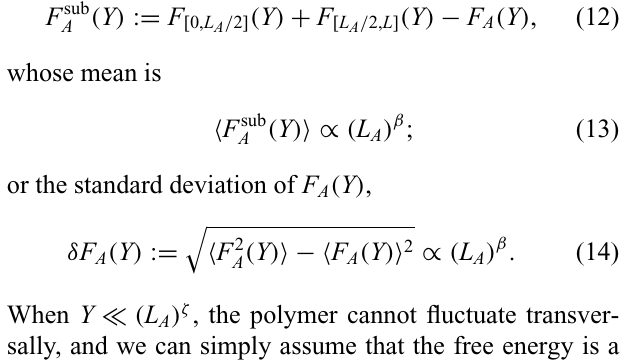
FIG. 3. Directed polymer in a finite strip, with heights Y (cid:13) L ζ (left) and Y (cid:14) L ζ (right), A